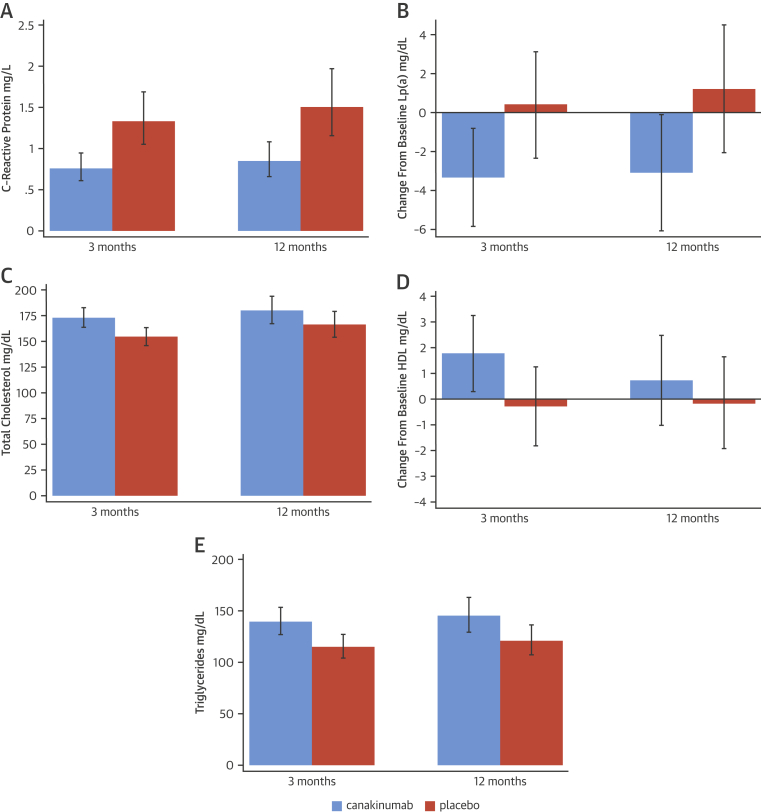
Changes in Lipids and C-Reactive ProteinAbsolute level or change from baseline at 3 and 12 months are shown for (A) C-reactive protein; (B) lipoprotein(a) (Lp[a]); (C) total cholesterol; (D) high-density lipoprotein (HDL) cholesterol; and (E) triglycerides.